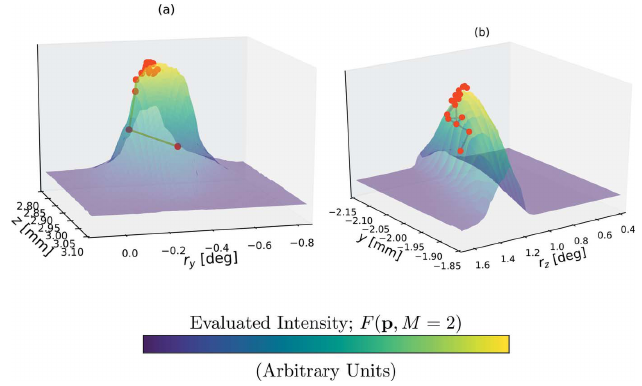
Figure 5 We present the route taken by Algorithm A.1 ascending the FOM (6). We overlaid the 16 sequential ‘best’ positions upon a surface plot of the raster scans. Panel ( a ) depicts the z and r y axes, and the y and r z axes can be seen in panel ( b ). The opacity of the surface was decreased so the full paths remain visible.